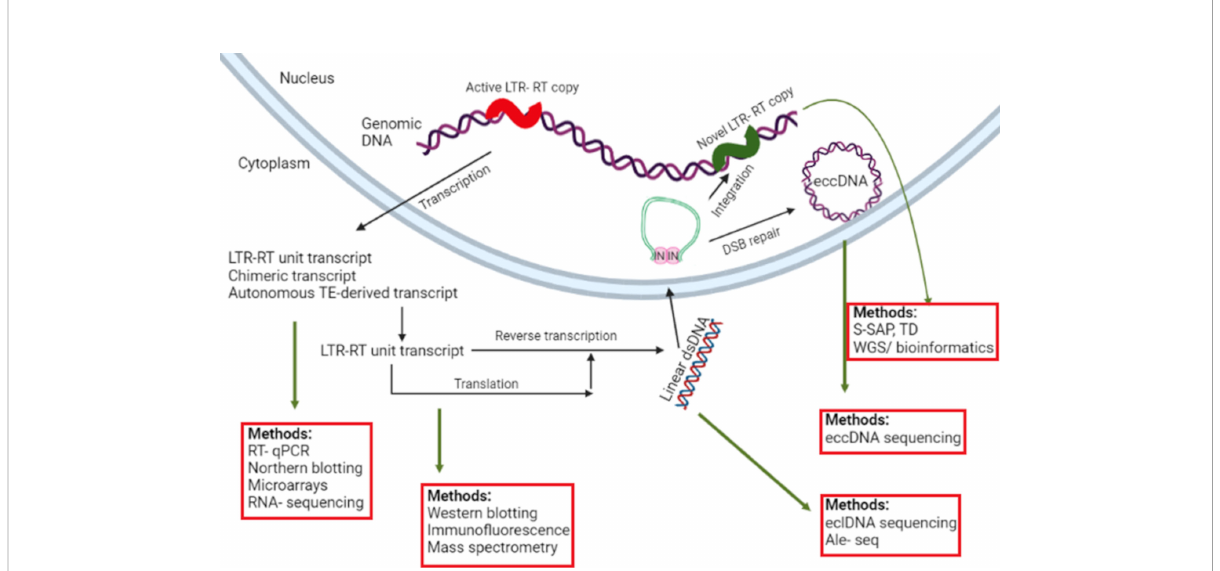
FIGURE 1 An overview of target molecules generated in the course of LTR-RT transposition and methods suitable for their detection. The meaning of individual abbreviations is as follows: LTR-RT, Long Terminal Repeat Retrotransposon; RT-qPCR, Reverse Transcription – quantitative PCR; IN, integrase; DSB, Double Strand Break; eclDNA, Extrachromosomal Linear DNA; eccDNA, extrachromosomal circular DNA; S-SAP, Sequence- Speci fi c Ampli fi cation Polymorphism; TD, transposon display; WGS, Whole Genome Sequencing; ALE-Seq, Ampli fi cation of LTR of eclDNAs followed by